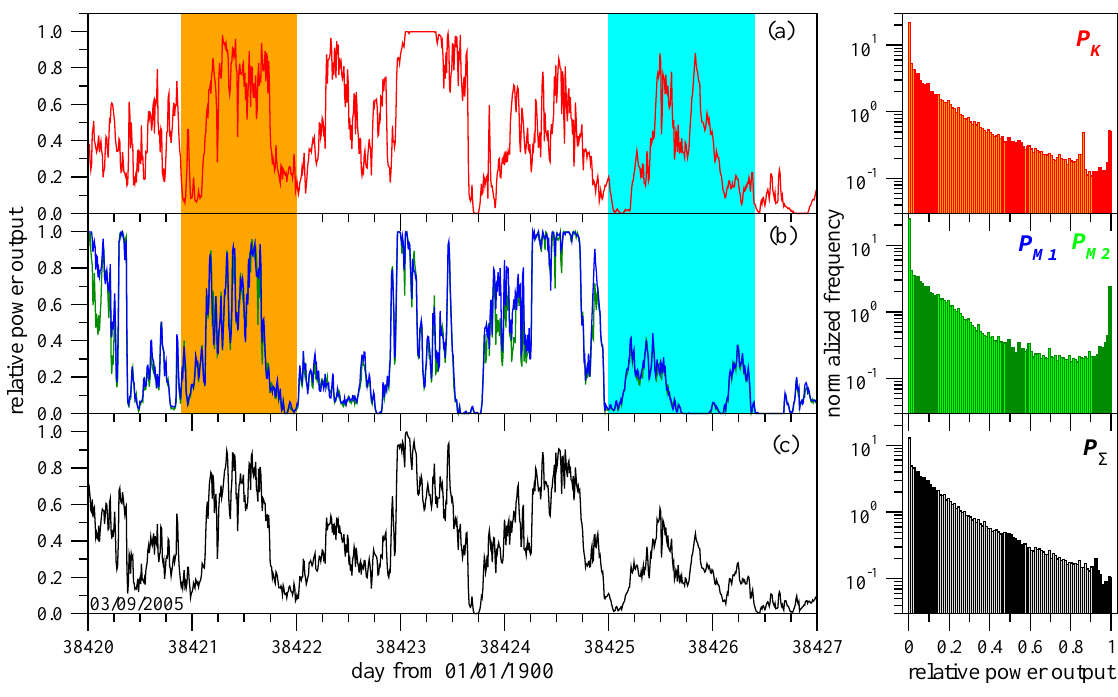
Figure 2. Relative power output (instantaneous measured value normalized by the measured peak power of 620 kW) for a period of one week beginning on 03/09/2005. (a) Turbine K , (b) turbines M 1 (green) and M 2 (blue), and (c) “integrated” power [see Equation (1)]. Orange (cyan) shading indicates almost synchronous (counter-phase) production. The probability density distributions (normalized frequencies) are shown on the right side, for the full record lengths indicated in Figure